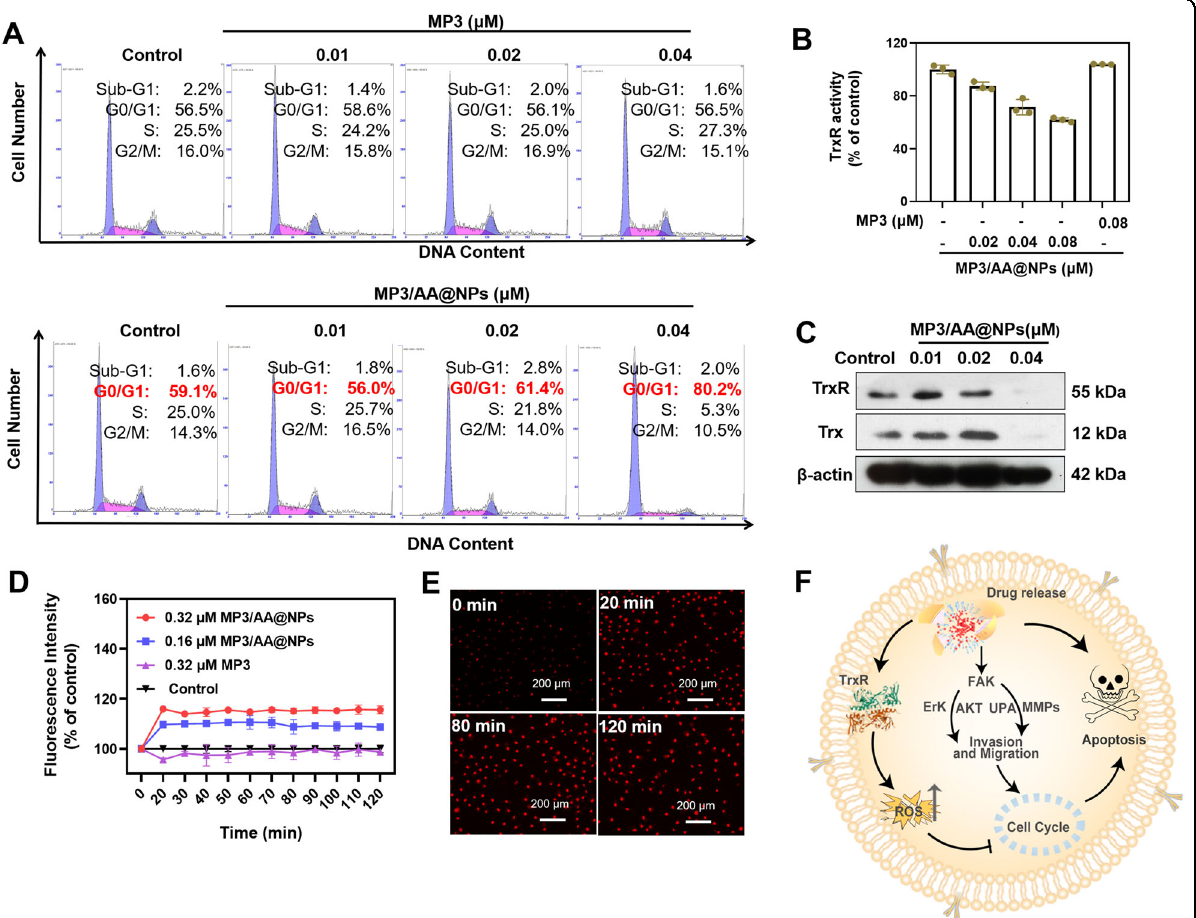
Fig. 5 The inhibitory activity of nanoparticles on TrxR and ROS generation. A The results of cell cycle, B the inhibition of TrxR activity, D the time-dependent ROS accumulation, and E the corresponding live imaging of MDA-MB-231 cells after treatment with various concentrations of MP3 or MP3/AA@NPs. C Western blot text of TrxR and Trx protein expression in MDA-MB-231 cells treated with MP3@PLGA/ACPP/AE105. F The mechanism diagram of the inhibitory effect of MP3/AA@NPs on MDA-MB-231